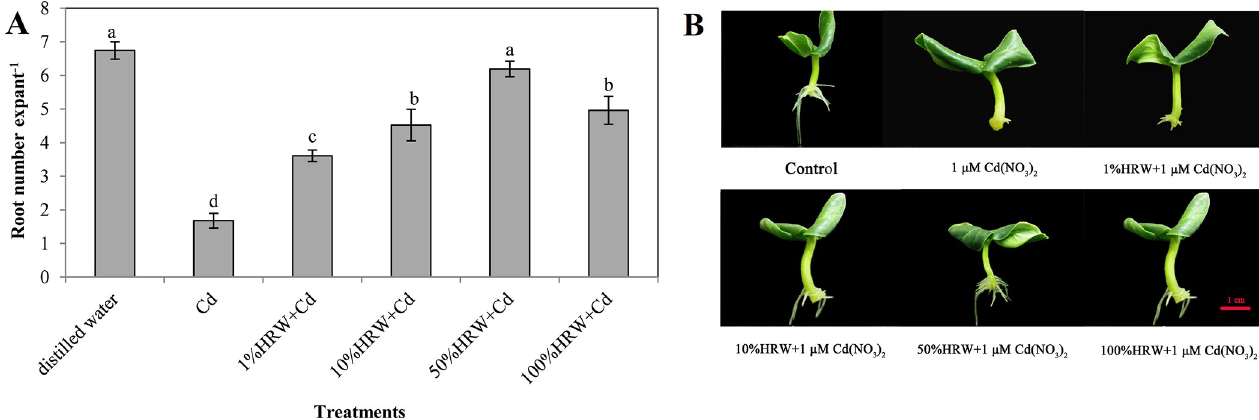
Fig 2. Effects of different concentrations of HRW on the adventitious rooting in cucumber explants under Cd stress. The primary roots were removed from hypocotyls of 5-day-old cucumber seedlings. Explants were incubated for 5d with distilled water (control) or different concentrations of HRW and Cd (NO 3 ) 2 co-treatment (1 μ M Cd(NO 3 ) 2 ,1% HRW+1 μ M Cd(NO 3 ) 2 , 10% HRW+1 μ M Cd(NO 3 ) 2 , 50%HRW+1 μ M Cd(NO 3 ) 2 and 100%HRW+1 μ M Cd(NO 3 ) 2 ). Adventitious root numbers ( A ) were expressed as mean ± SE. Bars not sharing the same letters were significantly different ( P < 0.05). Photos ( B ) were taken 5 days after the treatment, bar =